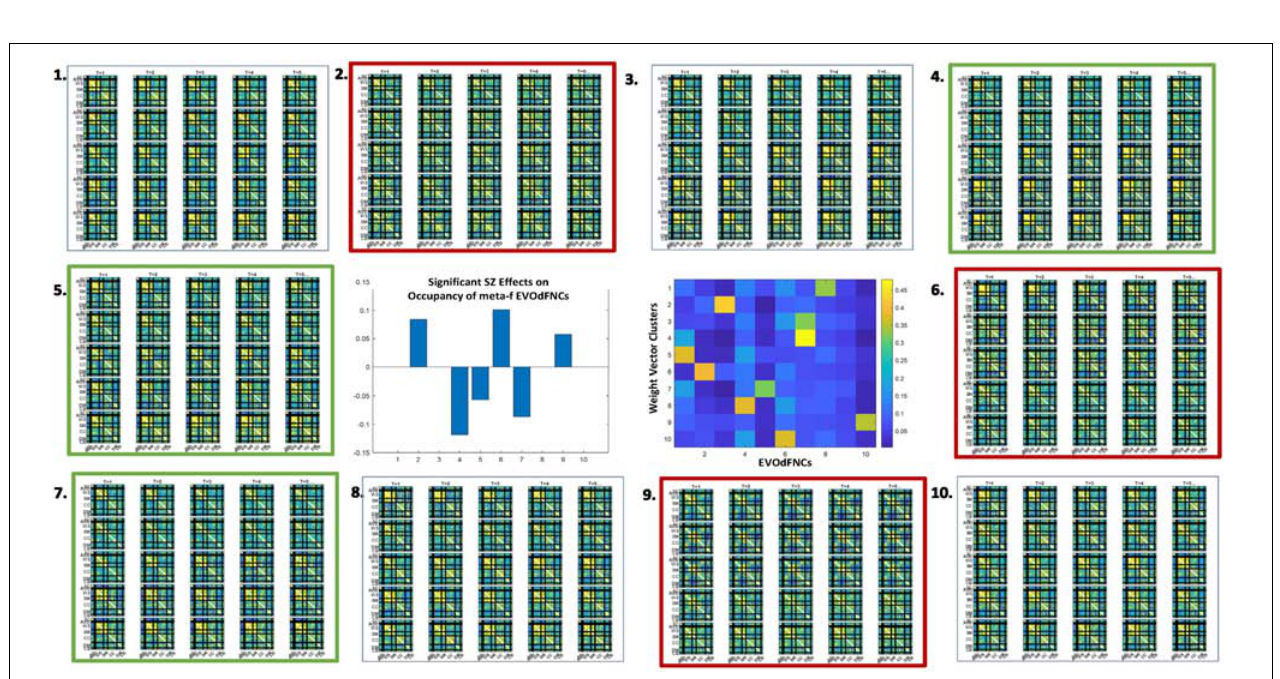
FIGURE 14 | As with representational importance of EVOdFNCs, we see many significant group differences between schizophrenia patients and controls in the occupancy rates of meta-EVOdFNCs; thick red (respectively, thick green) boxes designate significant positive (respectively, negative) effect of SZ on meta-EVOdFNC occupancy rate; all displayed effects are significant at the p < 0 . 05 level after correction for multiple comparisons. The cluster centroids of the EVOdFNC weight vectors from which the meta-EVOdFNCs (middle row, column 3) are induced tend to focus the majority of weight on one EVOdFNC, so there is evident resemblance between meta-EVOdFNCs and the EVOdFNCs. Note that positive symptoms exhibit no significant ( p < 0.05, uncorrected) effects on the occupancy rates of the SNAPdFNCs.